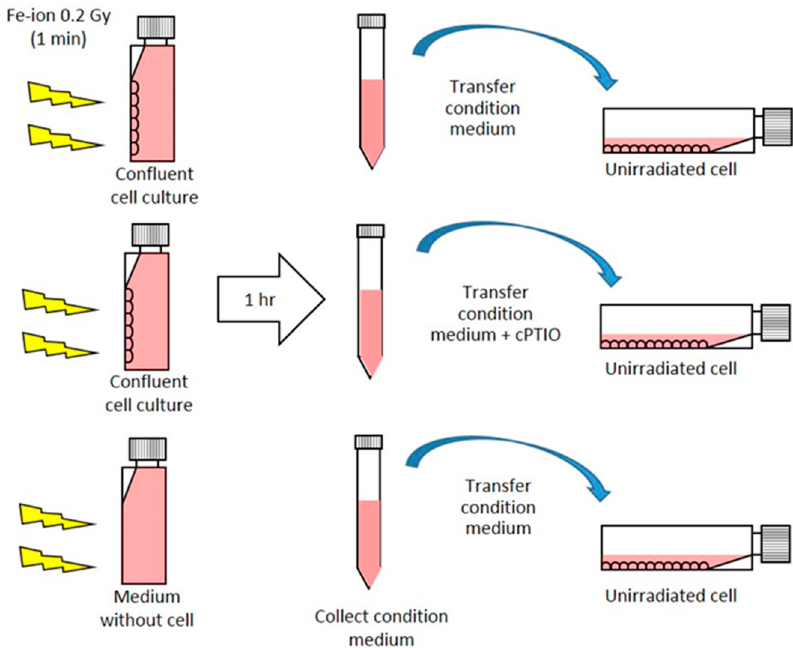
Figure 2. Scheme of media transfer experiment. Conditioned media exposed and collected from cell culture or medium only to 0.2 Gy Fe-ion were transferred to un-irradiated cells. To test involvement of NTE in CA, media were taken from 0.2 Gy Fe-ion exposed culture at 1 hr after exposure and transferred to non-irradiated cells (Figures 2 and 3, Table 1). Table 1a. Whole genome equivalent for frequency of CA per 100 cells in fibroblasts of 0.2 Gy Fe-ion (1000 MeV/u) exposure with and without the NO scavenger, 2-(4-Carboxyphenyl)-4,4,5,5- tetramethylimidazoline-1-oxyl-3-oxide potassium salt (cPTIO) added to the medium. Dose (Gy)